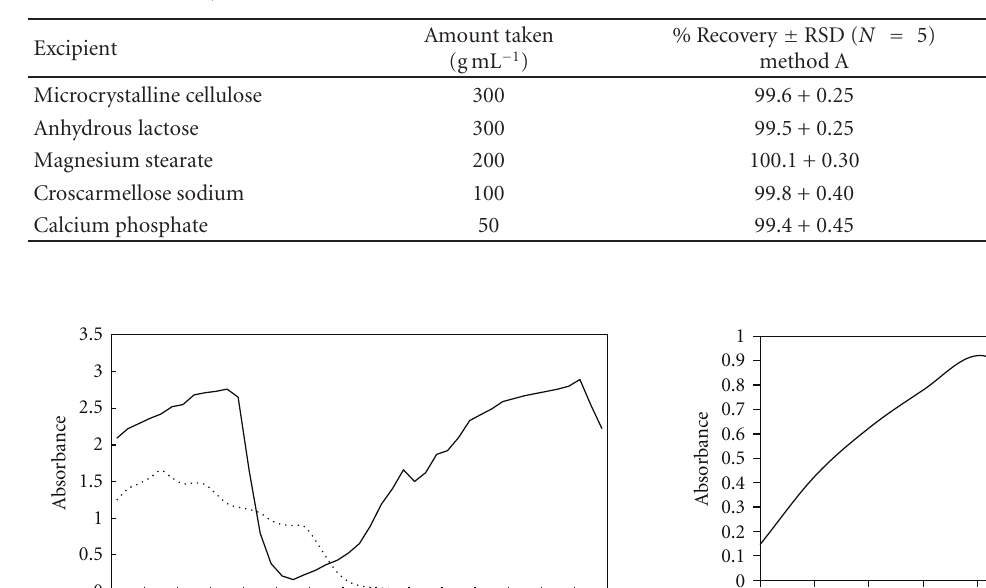
Table 2: Determination of alendronate sodium in the presence of possible excipients (5 μ g mL − 1 of alendronate sodium was taken for interferences studies).